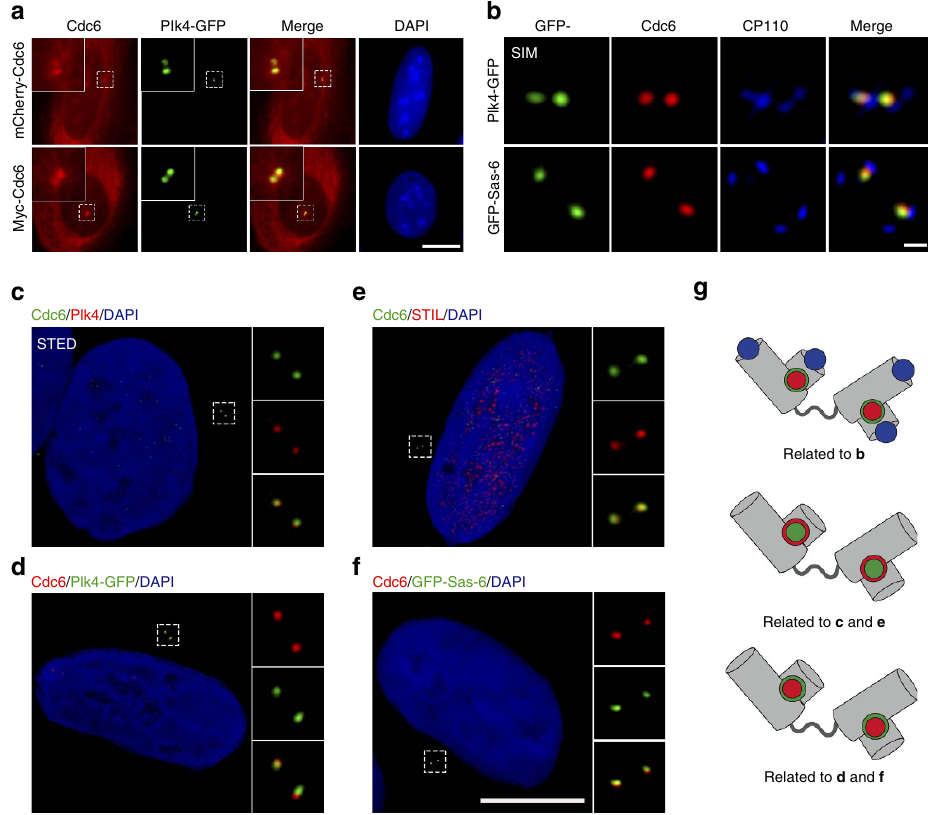
Figure 3 | Cdc6 colocalizes with Plk4 and cartwheel proteins Sas-6 and STIL during S phase. ( a ) Cdc6 colocalizes with Plk4. U2OS cells were co-transfected with mCherry-tagged Cdc6 (upper panel) or Myc-tagged Cdc6 (lower panel) with GFP-tagged Plk4. Myc-tagged Cdc6 was stained with a Myc antibody. ( b ) Cdc6 colocalizes with Plk4 and Sas-6 viewed by 3D-SIM. 3D-SIM images of U2OS cells transfected with GFP-tagged Plk4 (upper panel) or GFP-tagged Sas-6 (lower panel) and stained for endogenous Cdc6 and CP110. ( c – f ) Cdc6 colocalizes with Plk4, STIL and Sas-6 viewed by STED. Immunofluorescence of endogenous Cdc6 (green) and Plk4 (red), or Cdc6 (green) and STIL (red) in U2OS cells ( c , e ). Immunofluorescence of endogenous Cdc6 (red) in U2OS cells transfected with GFP-tagged Plk4 or GFP-tagged Sas-6 ( d , f ). ( g ) Schematic diagrams illustrating the localization of proteins at the centrosome in b – f . Different proteins are indicated by the colours of staining in b – f . DNA was stained with DAPI. Scale bars in a , c – f , 10 m m. Scale bar in b , 0.2 m m. Insets in a , c – f are high-magnification views of the regions indicated in the low-magnification (Supplementary Fig. 4d) 43 . We first tested in cells the phosphorylation of Cdc6 WT, a single mutation of serine 30 to alanine (S30A), a single mutation of threonine 527 to alanine (T527A) and a double mutation of S30A and T527A (denoted as 2A) mutants using Phos-Tag acrylamide assay. As shown in Fig. 4f, the slower mobility shift band represents phosphorylated Cdc6, the faster mobility shift band represents unphosphorylated Cdc6. Cdc6 S30A or T527A mutant partially decreased Cdc6 phosphorylation compared to Cdc6 WT, and the Cdc6 2A double alanine mutant further decreased Cdc6 phosphorylation (Fig. 4f).